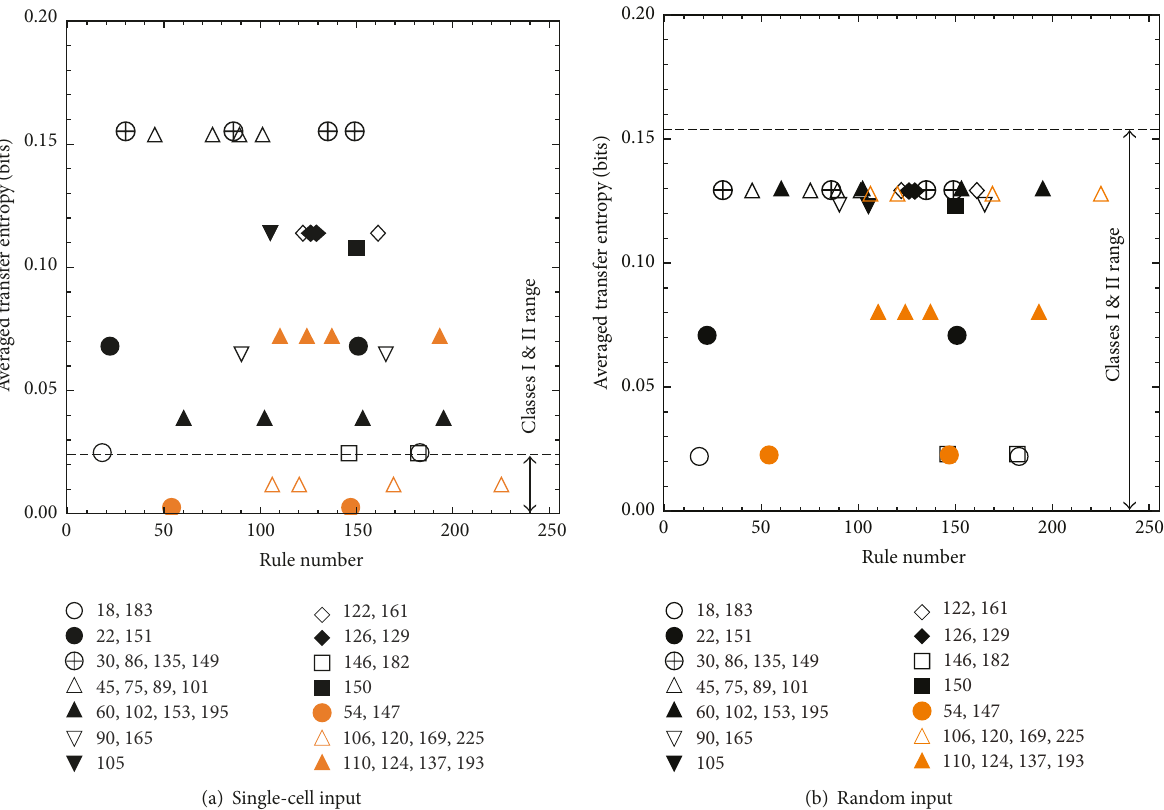
Figure 2: ⟨ TE ⟩ for each rule, shown for two different inputs: single cell (a) (either one black cell or one white cell) and random (b). Equivalent rules are represented by a common marker. The association of equivalent inputs with equivalent rules is chosen heuristically as the one that maximizes the averaged TE. The dashed line corresponds to the highest value of ⟨ TE ⟩ for any Wolfram Class I or II rule. Individual markers are shown only for Wolfram Classes III (black) and IV (orange)